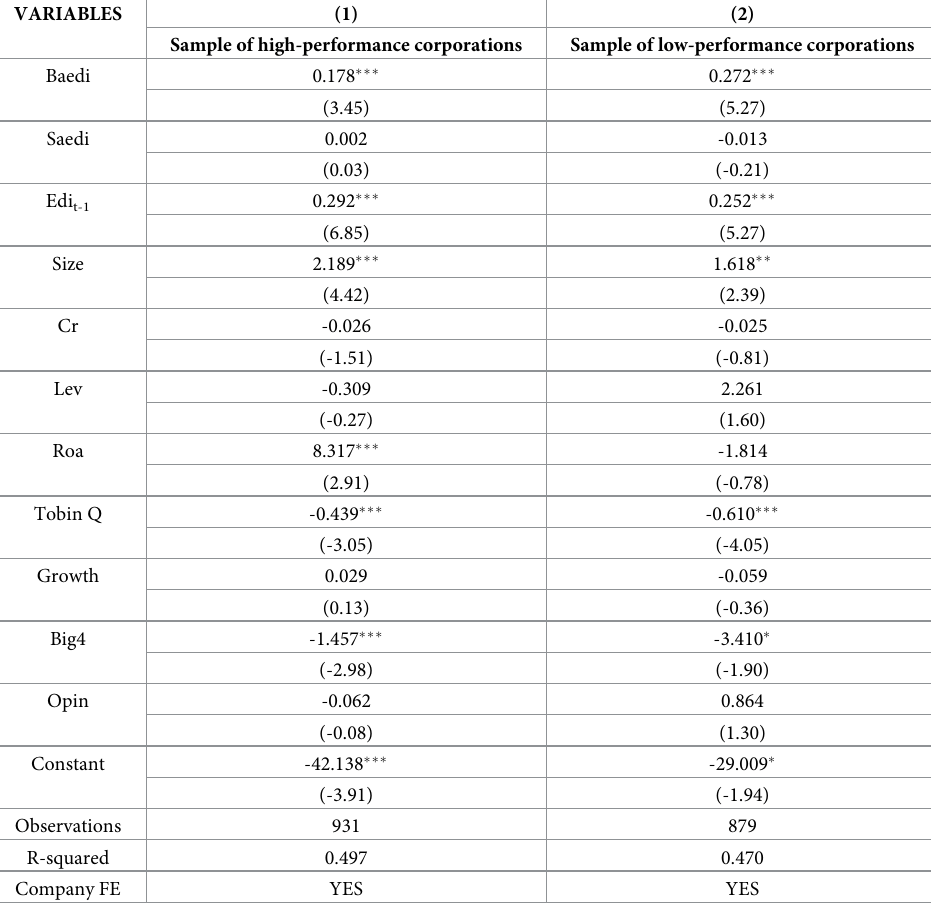
Table 9. Grouping regression results of corporate governance